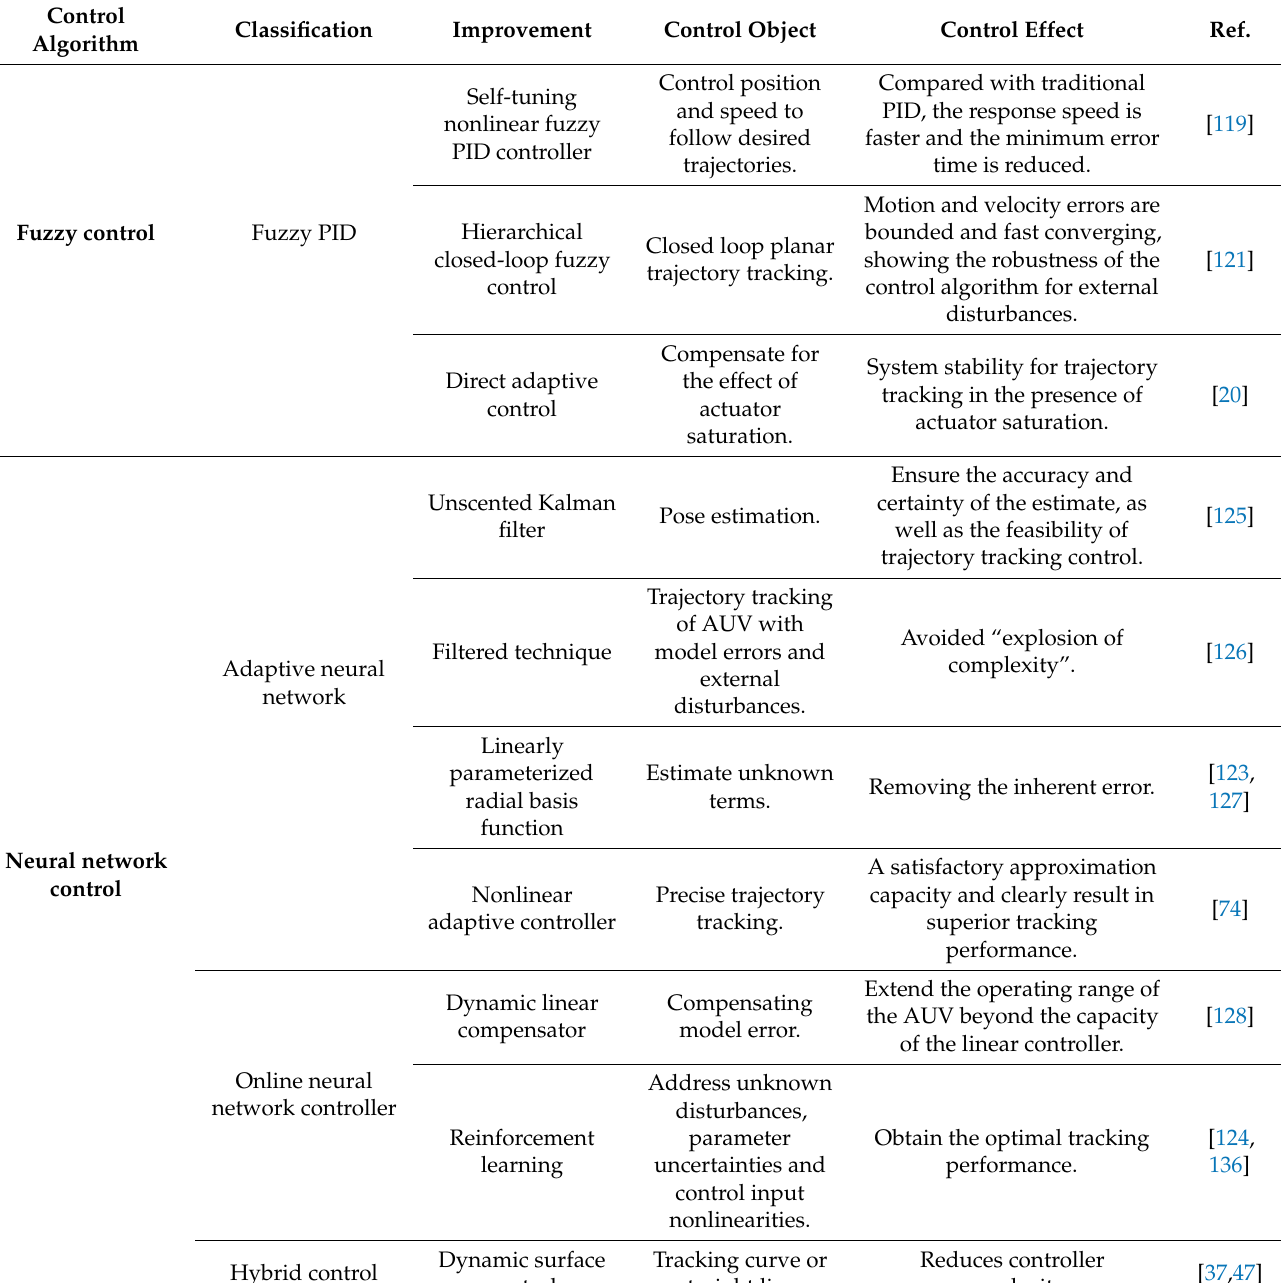
Table 5. Intelligent control algorithm in AUV trajectory